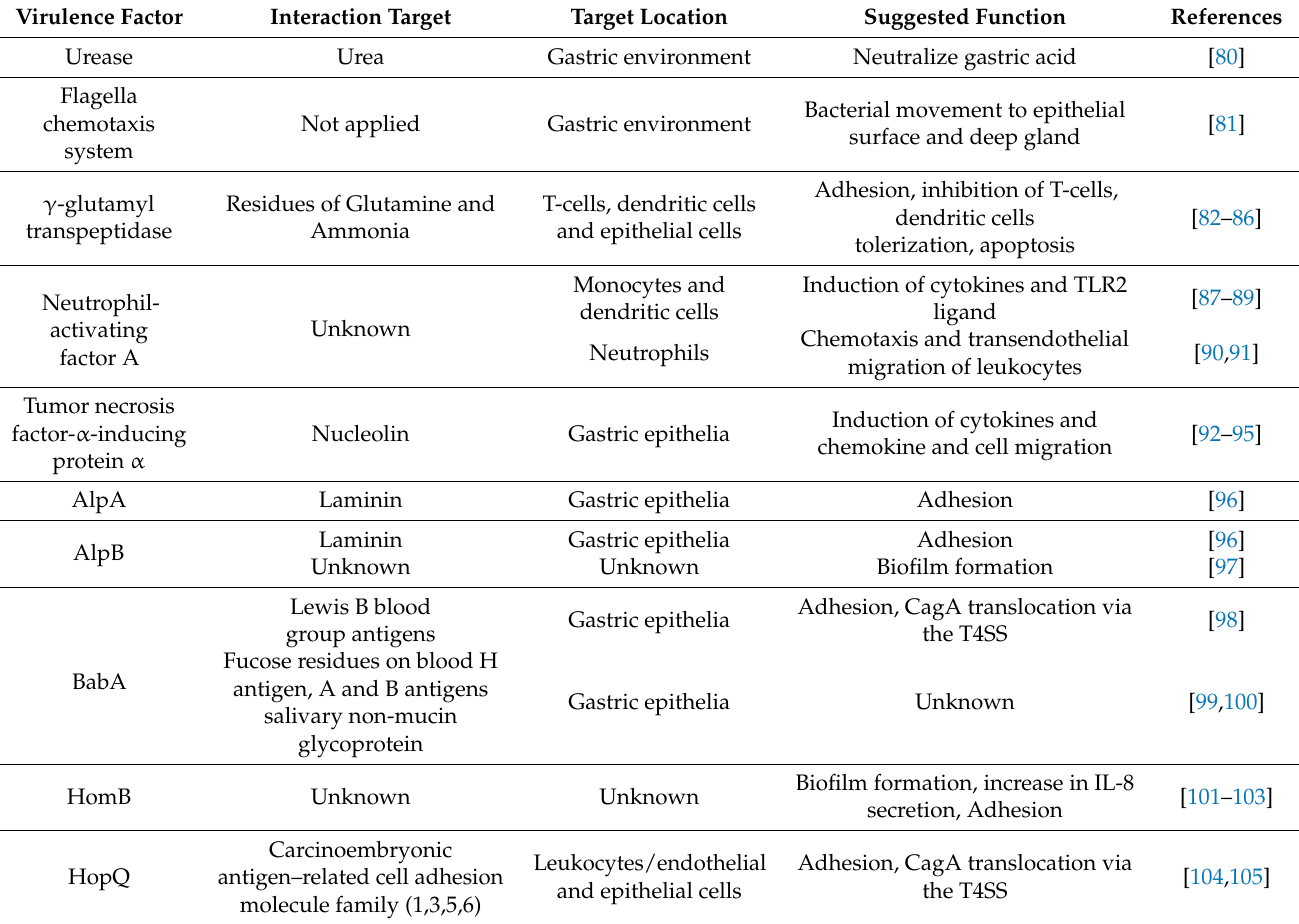
Table 1. Main H. pylori virulence factors along with the respective interaction receptor and location, and suggested